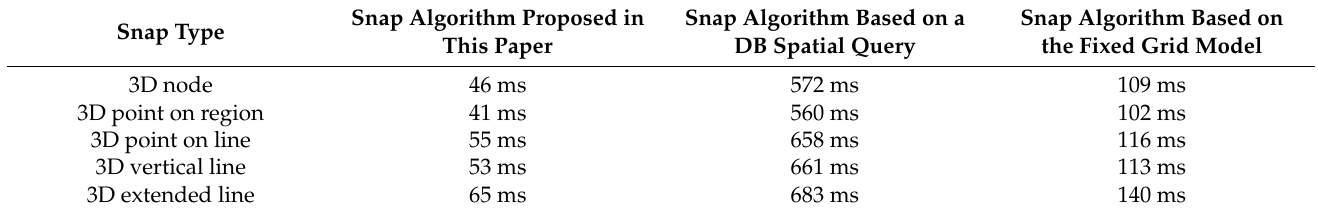
Table 1. Average time consumption of the three snap algorithms for twenty times.